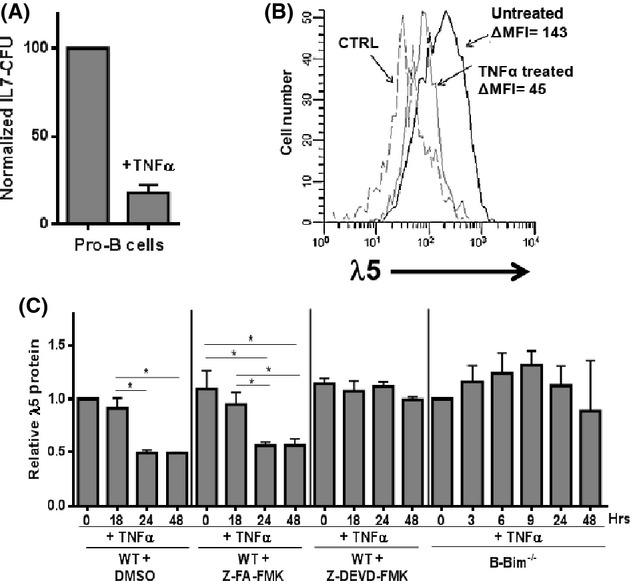
TNFα induces apoptosis preferentially in pro-B cells which express relatively high levels of λ5 surrogate light chain. (A) Bone marrow pro-B cells from young adult (3 months) B6 mice were cultured in IL-7 CFU assays (1 × 105 ml−1) with or without 10 ng ml−1 rmTNFα. The IL-7-dependent colonies were harvested at day 8. (B) Remaining IL-7 CFU shown in (A) experiments were stained for pro-B-cell markers as well as cytoplasmic λ5. Pro-B-cell cytoplasmic λ5 expression is shown for untreated and rmTNFα-treated groups. CTRL, isotype control staining. Data are representative of five experiments. (C) CD19+ cells from young wild-type (WT) or B-Bim knockout mice were cultured with 5 ng ml−1 rmIL-7 and DMSO (0.5% final concentration) either alone or with 10 ng ml−1 rmTNFα and, where shown, 50 mm Z-FA-FMK (control) in DMSO or 50 mm Z-DEVD-FMK (caspase 3 inhibitor) in DMSO for the times indicated. Harvested B-lineage cells were stained for cytoplasmic λ5 protein with the Δmean fluorescence intensity (MFI) determined. Time zero values for λ5 were set at 1.0. Relative λ5 protein values, based on ΔMFI values, were obtained in 3–4 separate experiments for each group. P values (two-tailed Student's t-test) were: *P < 0.05.